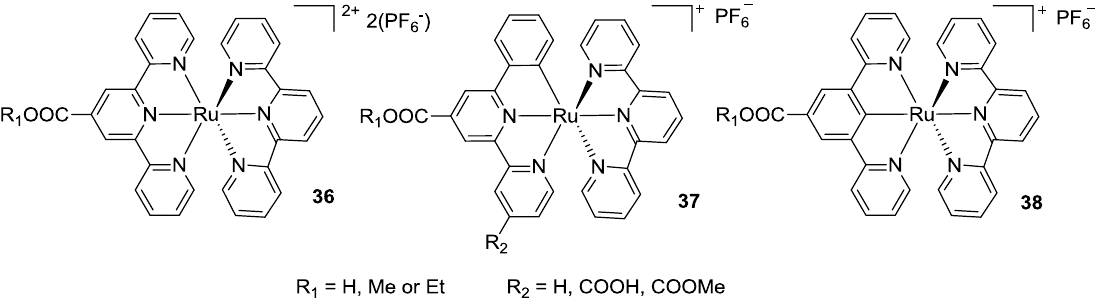
Figure 27. Tpy and phenyl-bipyridines complexes investigated by Wadman et al. [132].